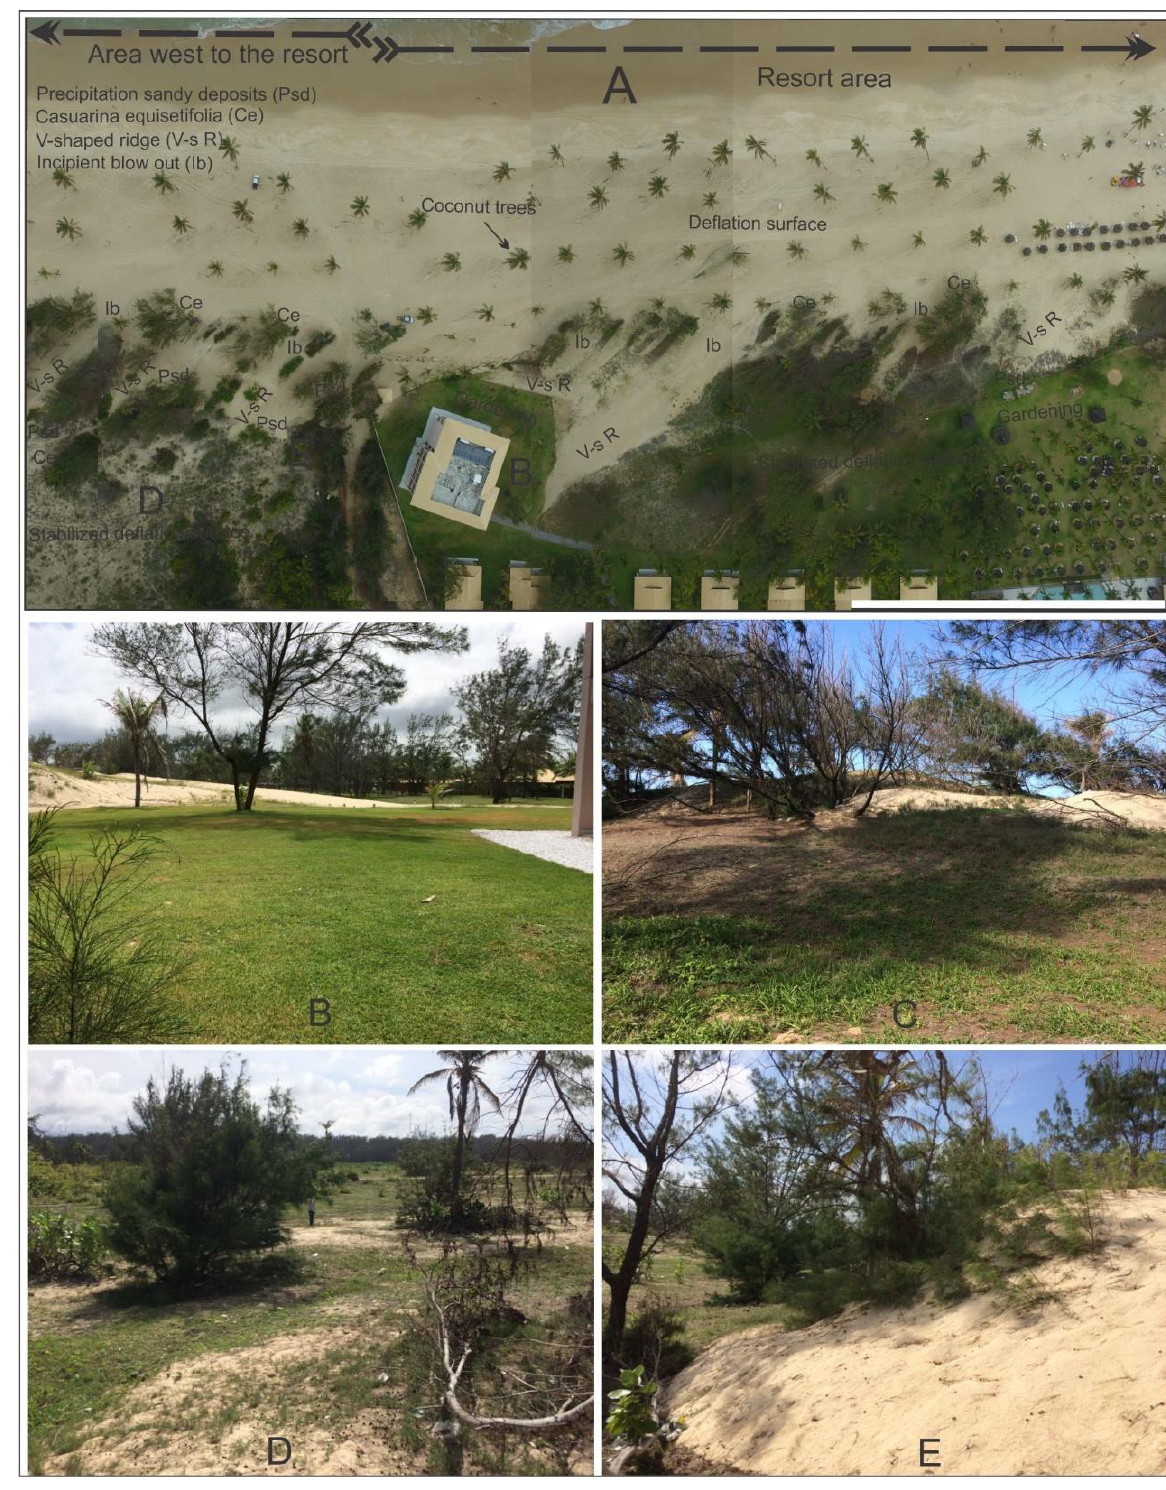
Figure 5. The photographs shown in Figure 5 ( A – E ) show low terraces formed by the dissipation of sand along preferential wind corridors, producing low V-shaped ridges ( A , B ) and depositional lobes ( C ), sandy terraces over the stabilized deflation plain ( D ), and retention or precipitation sandy deposits, as well as lobe deposits, ( E ) Cumbuco Beach.